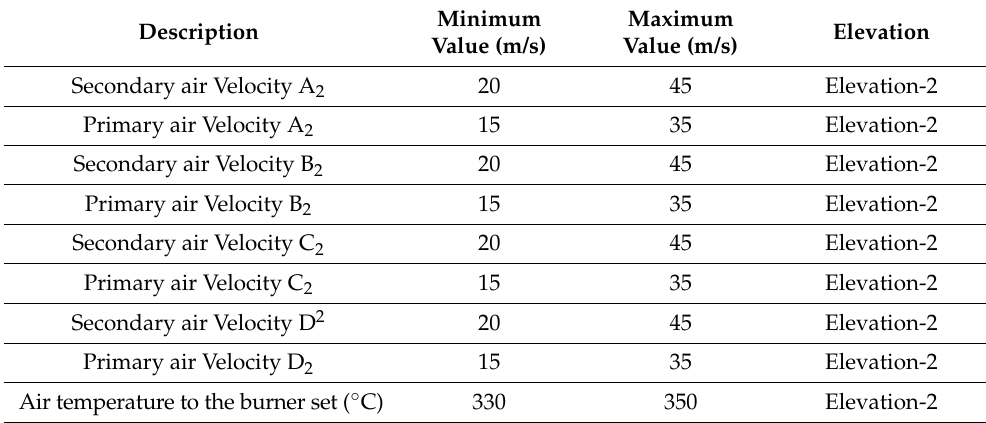
Table 7. Burner’s operating parameters range, elevation-wise.